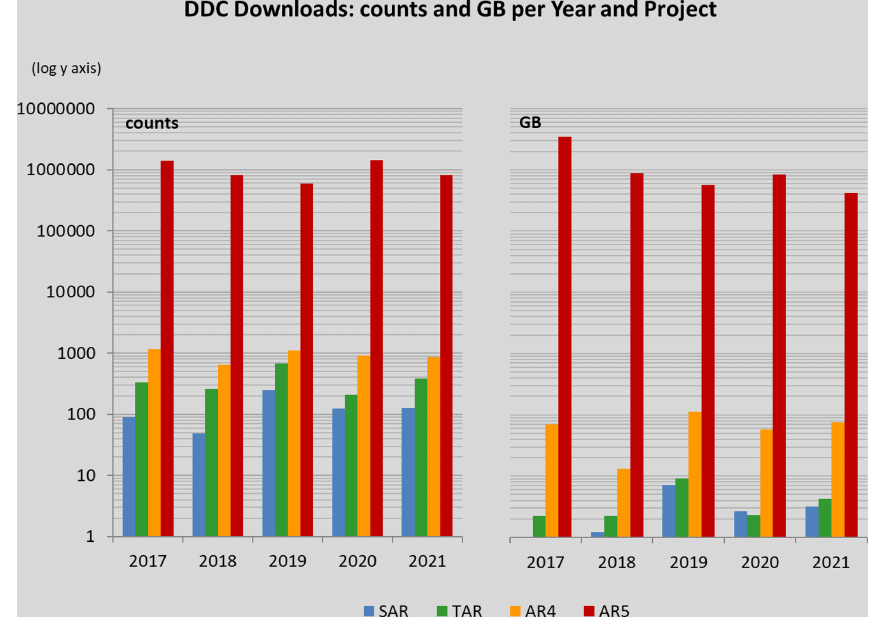
Figure 4. Downloads in number of datasets (counts) and data volume (GB) from the DDC Reference Data Archive over the last 5 years per Assessment Report (FAR is left out because of the incomplete Reference Archive and AR6 including SR1.5 because of the ongoing data archiving; Stockhause,